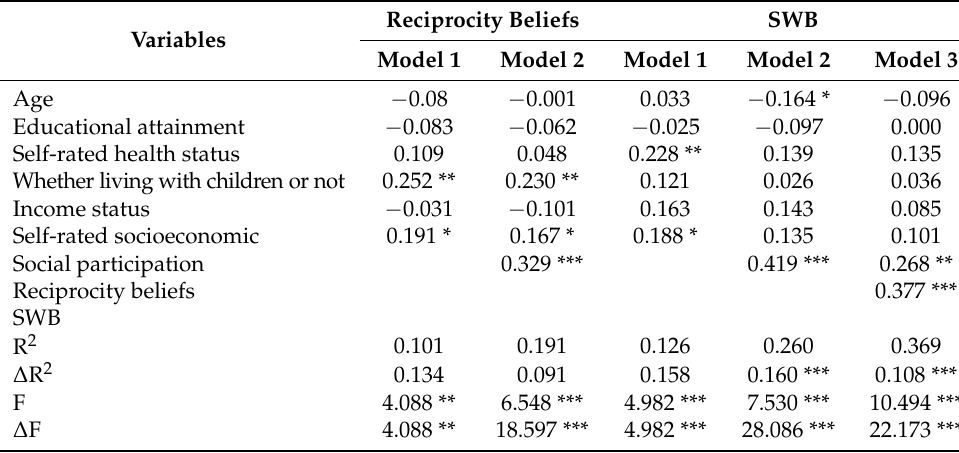
Table 5. Multiple linear regression analysis results in older women.